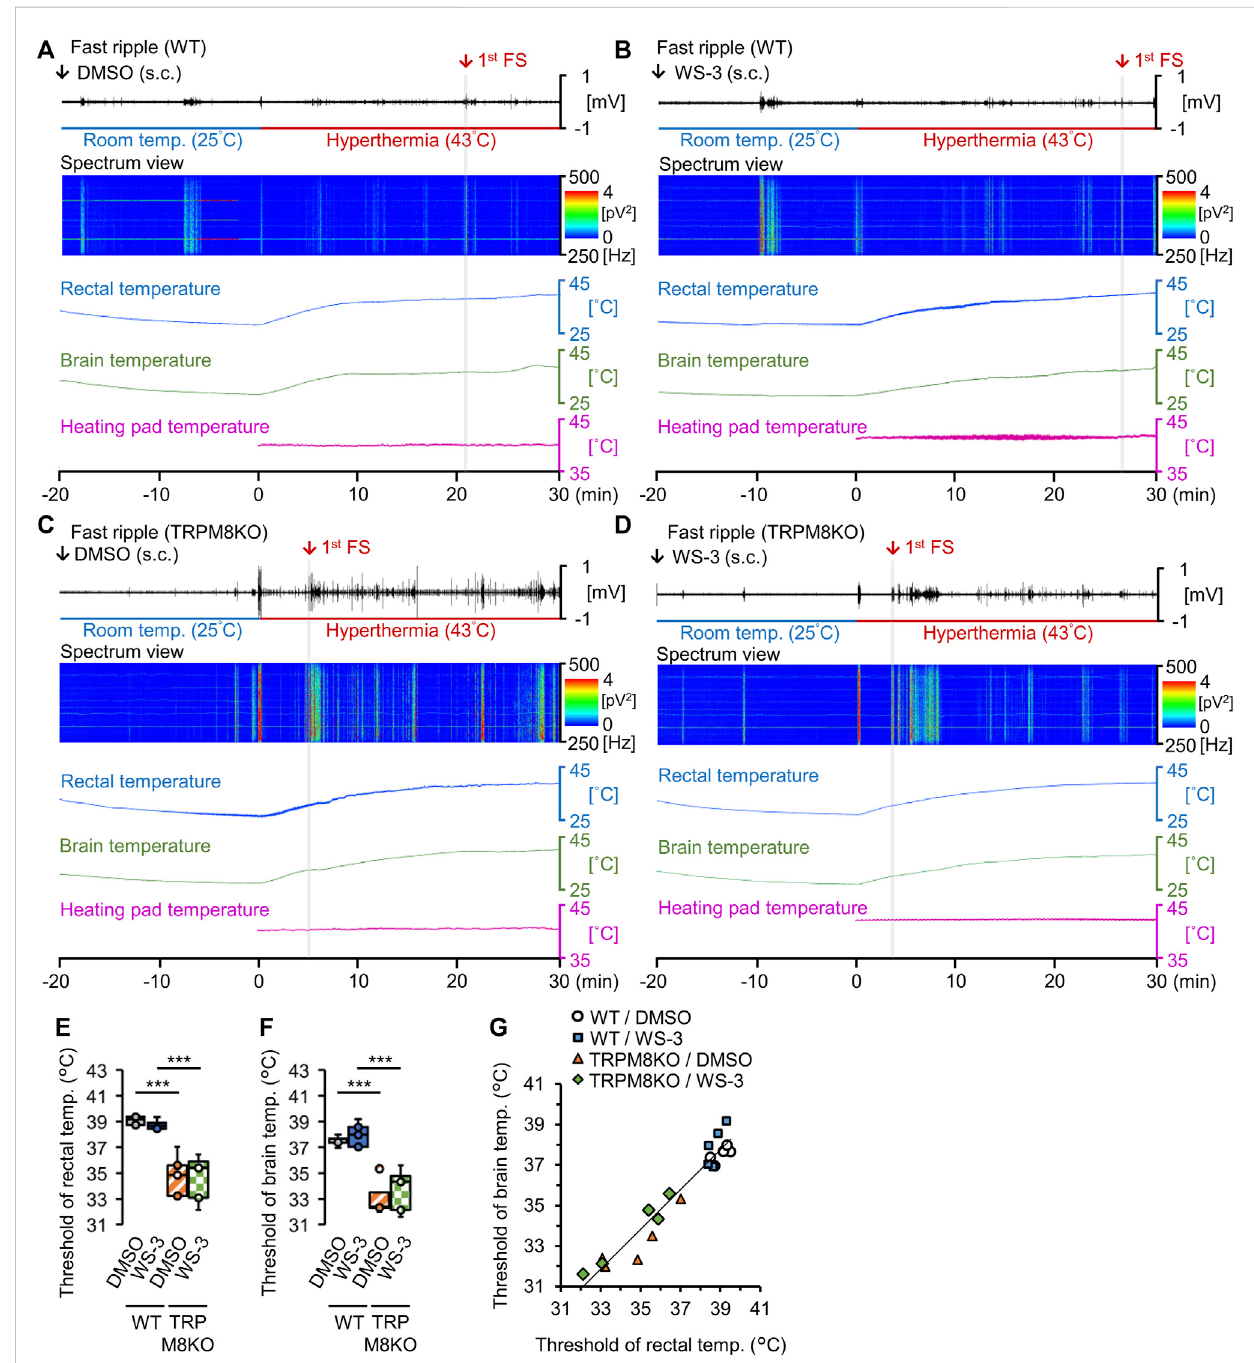
FIGURE 3 Effectsofthetransientreceptorpotential melastatin8(TRPM8) agonistandTRPM8 de fi ciency onrectalandbraintemperature thresholdsunderthe hyperthermic condition. (A – D) Representative trends in fast ripple amplitudes, power spectra for the fast ripple band, and rectal, brain, and heating pad temperatures in (A) wild-type (WT) mouse/dimethyl sulfoxide (DMSO) and (B) WT/WS-3 groups, and (C) TRPM8 knockout (TRPM8KO) mouse/ (D) DMSO andTRPM8KO/WS-3groups.Redarrowsandgraycolumnsindicatethetimerequiredforhyperthermiatoinducethe fi rstfebrileseizure(FS)ineach group. Rectal (E) and brain (F) temperature thresholds for the fi rst FS induced by hyperthermia in the WT/DMSO (white: n = 5) and WT/WS-3 (blue: n = 5) groups, and TRPM8KO/DMSO (orange oblique line: n = 5) and TRPM8KO/WS-3 (green squares: n = 5) groups. (G) Correlation between the rectal and braintemperaturethresholdsfor the fi rstFSinducedbyhyperthermiaineachgroup intheWT/DMSO (whitecircle: n = 5)and WT/WS-3 (blue square: n = 5) groups, and TRPM8KO/DMSO (orange triangle: n = 5) and TRPM8KO/WS-3 (green rhombus: n = 5)